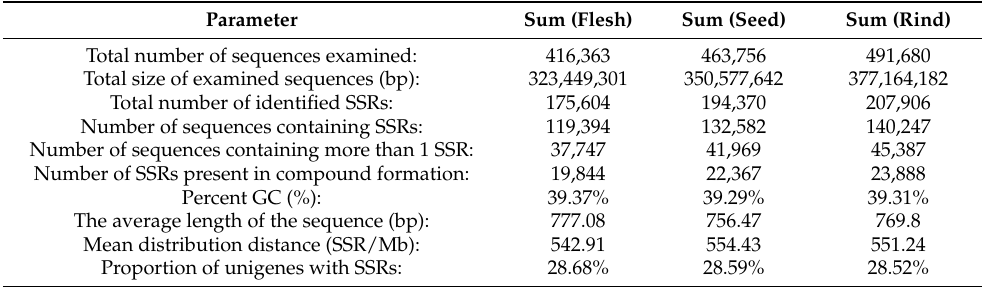
Table 1. De novo assembly results and SSR identification in A. trifoliata fruit